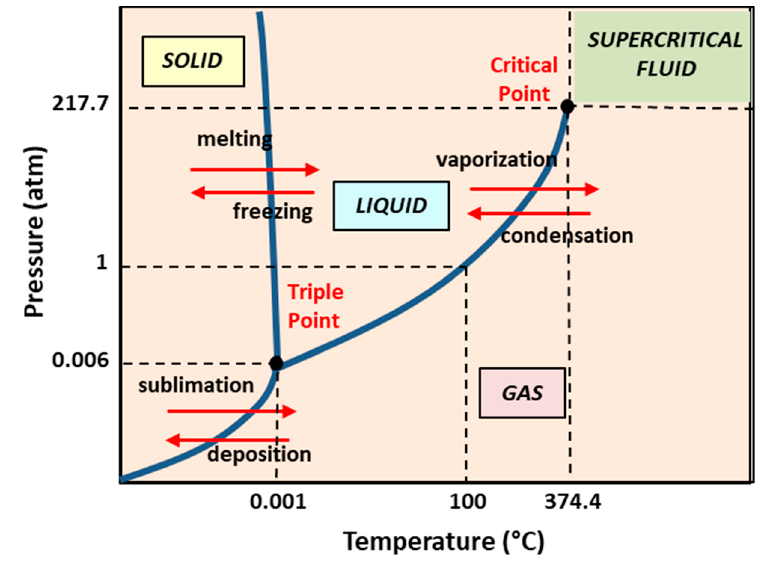
Figure 8. Phase diagram of carbon dioxide.